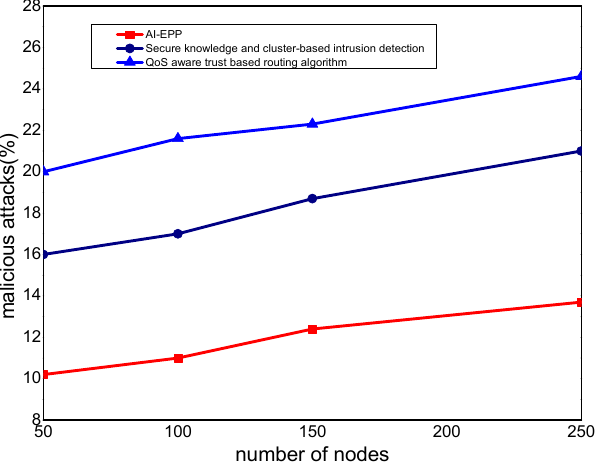
Figure 8. Energy consumption comparison using simulations with varying data rates.